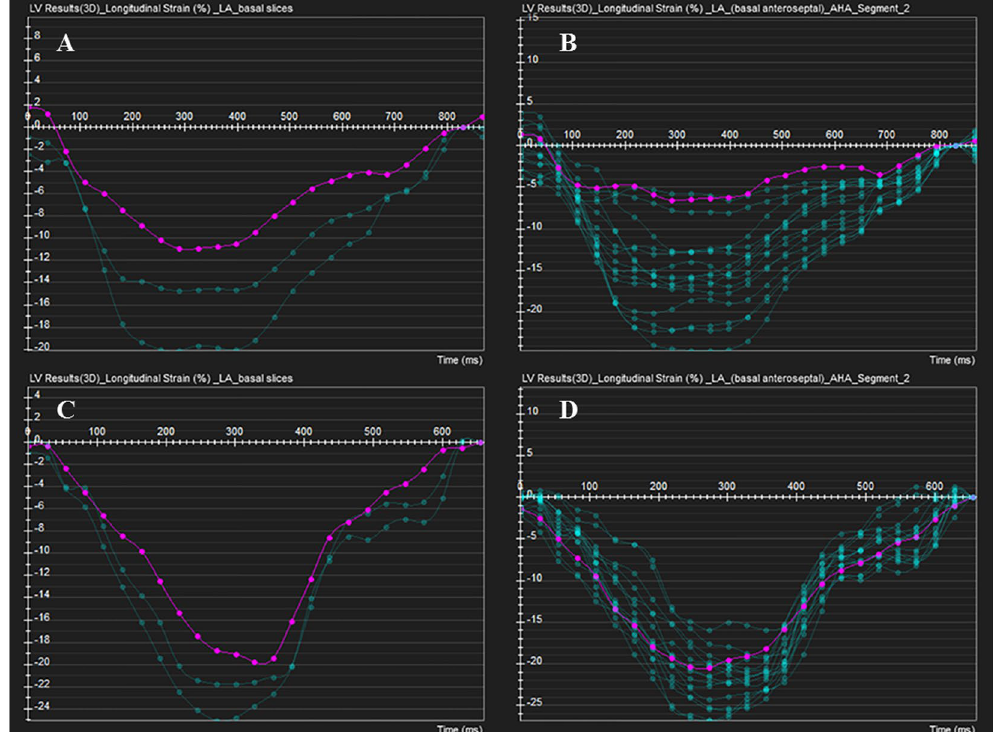
Figure 1. Feature tracking variables of longitudinal strain in AL-CA with preserved LVEF and normal control. ( A , B ) Red curve shows reduced longitudinal PS in LV base and basal anteroseptal segment, while the preserved longitudinal PS in apical segment could be observed. ( C , D ) No reduction of longitudinal PS in any three slices in normal